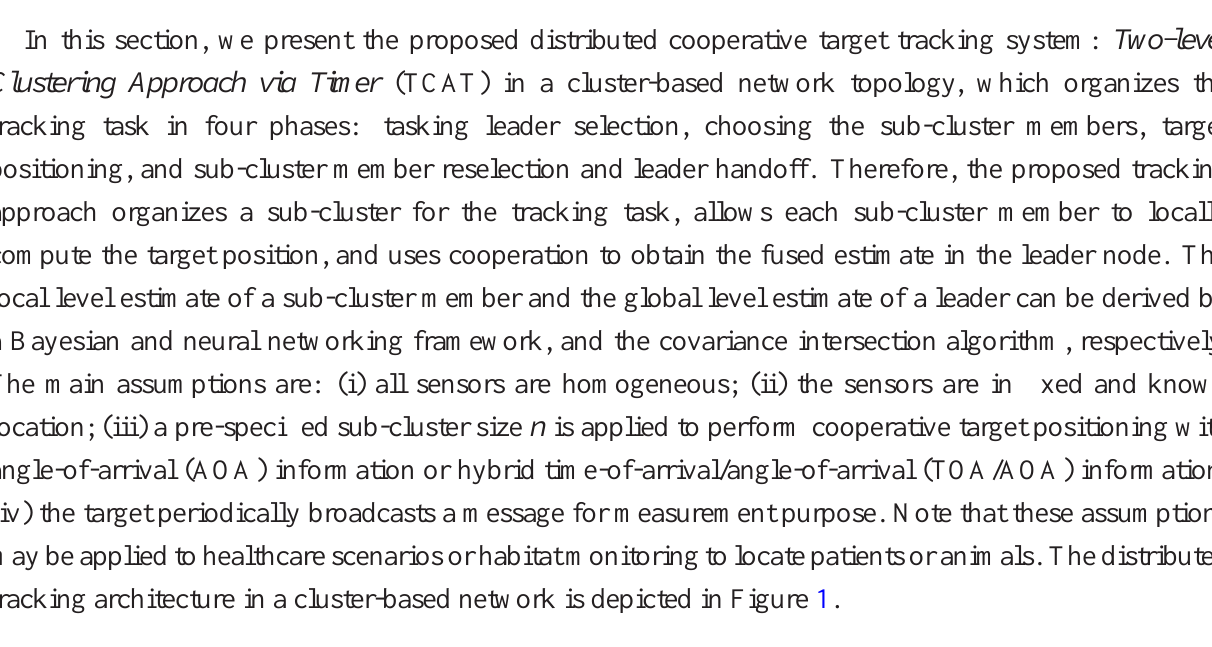
Figure 1. Illustration of block diagram for the TCAT